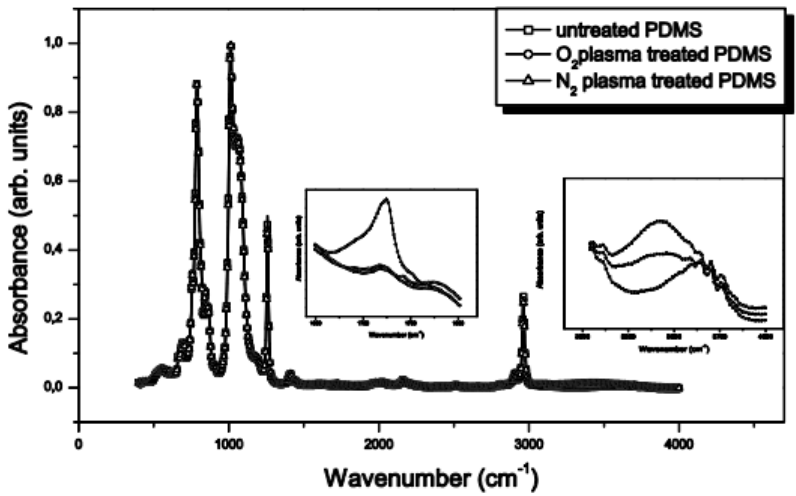
Figure 2. IR spectra of untreated, O 2 plasma and N 2 plasma treated PDMS. The left inset is magnification portion of the spectrum around 1730 cm −1 , showing characteristic carbonyl band. The right inset: zoom-in on the OH